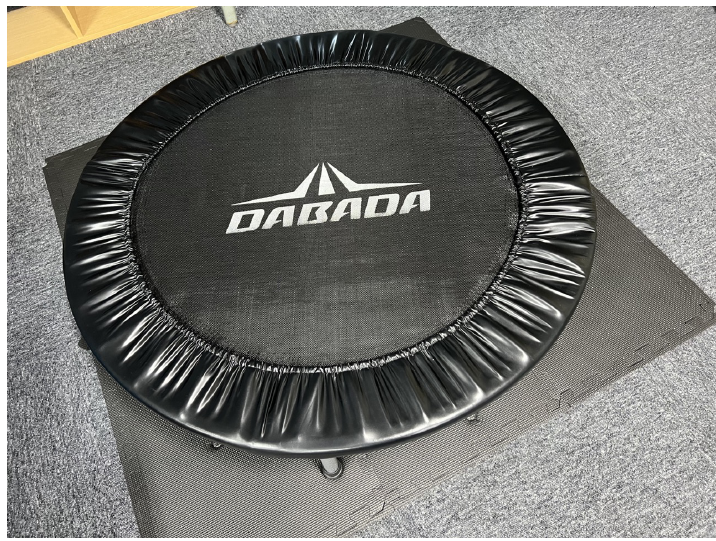
Figure 3. Home trampoline used in the